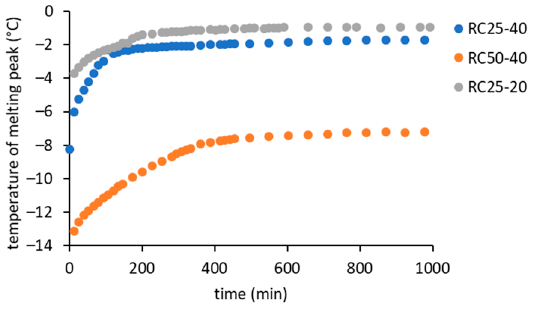
Figure 8. Increase of the melting point during the condensation of the studied RF mixtures.